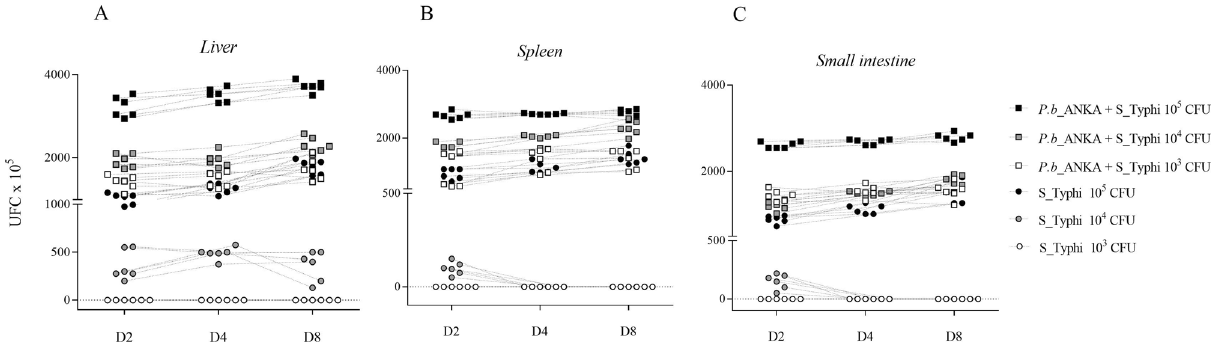
Figure 1. Plasmodium berghei ANKA and Salmonella enterica serovar Typhi coinfection model. In the malaria infection model developed, three groups of animals received an intraperitoneal dose of 10 6 erythrocytes infected with P. berghei ANKA on D0, and challenged with S_Typhi on D1. Group 1 received 10 5 S_Typhi CFUs on D1 (Pb + S_Typhi 10 5 ). Group 2 received 10 4 S_Typhi CFUs on D1 (Pb + S_Typhi 10 4 ), and Group 3 received 10 3 S_Typhi CFUs (Pb + S_ Typhi 10 3 ). Three other groups were challenged with only S_Typhi on D1, Group 4 (S_Typhi 10 5 ), Group 5 (S_Typhi 10 4 ) and Group 6 (S_Typhi 10 3 ). The animals were euthanized for